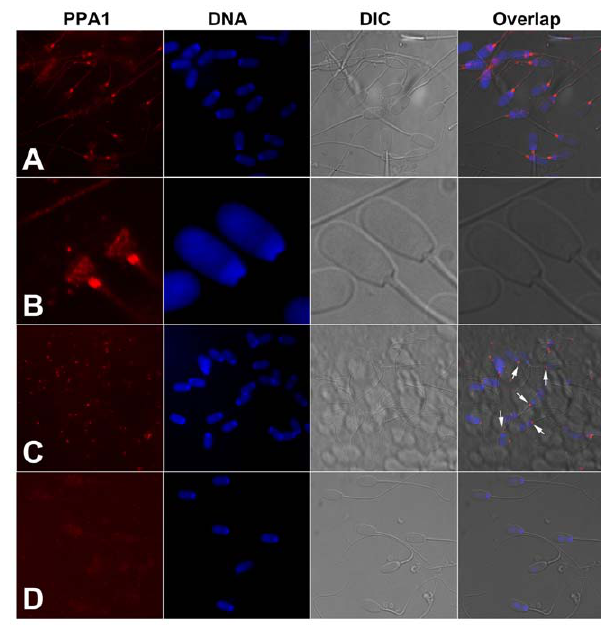
Figure 5. Localization of inorganic pyrophosphatase (PPA1; red) in spermatozoa by immunofluorescence. (A, B) Whole mount immunofluorescence of boar spermatozoa. Most prominent labeling is observed in the sperm tail connecting piece and in the postacrosomal sheath of the sperm head. (C) Identical labeling (arrows) is observed in spermatozoa attached to oocyte zona pellucida at 30 min after gamete mixing during IVF. (D) Negative control with anti-PPA1 antibody immunosaturated with full length PPA1 protein. DNA was counter- stained with DAPI (blue). Epifluorescence micrographs were overlapped with parfocal transmitted light photographs acquired with DIC optics. doi:10.1371/journal.pone.0034524.g005 sperm head and flagellum could support protein phosphorylation during sperm capacitation that is observed both in vitro and in vivo , in the oviductal sperm reservoir. Altogether, present studies suggest the